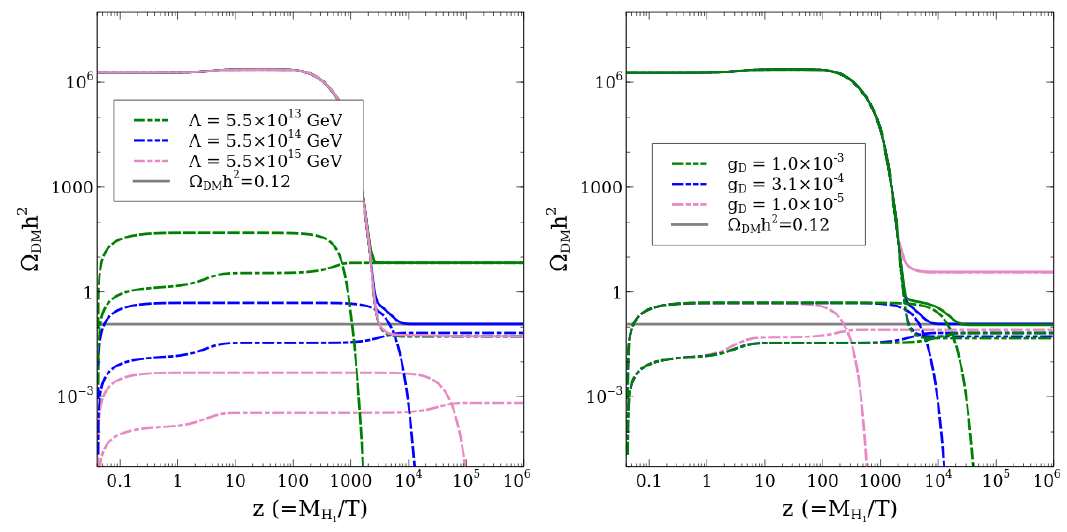
Figure 10 . Dependence of the DM relic densities on three different values of Λ (left) and the dark gauge coupling g (right). The other parameters are kept the same as those given in figure 8. The D double-dot-dashed (dot-dashed) lines represent the WIMP (FIMP) DM relic densities, while the dashed lines indicate the NLSP relic densities. The solid lines are the sum of the FIMP and WIMP DM relic densities, while the grey solid line denotes the current DM relic density of 0.12.